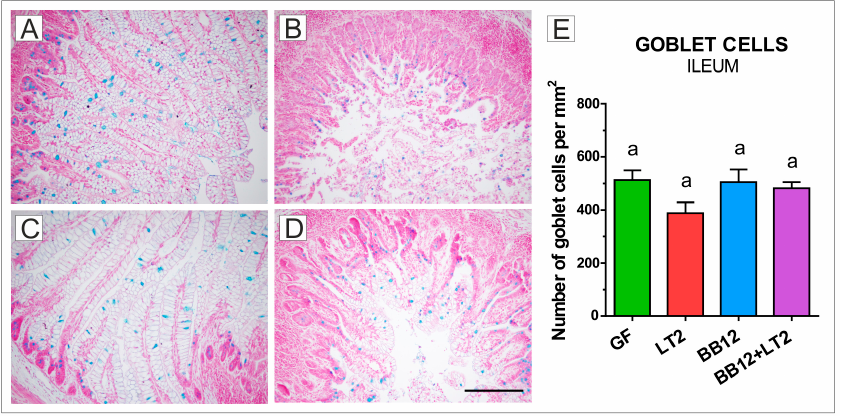
Figure 1. Goblet cells (blue color) in the ileum of gnotobiotic piglets. Number of goblet cells per mm 2 in the ileum of the one-week-old piglets: germ-free (GF; ( A )), infected with S . Typhimurium LT2 for 24 h (LT2; ( B )), associated with B. animalis subsp. lactis BB-12 (BB12; ( C )), and associated with BB12 and infected with LT2 for 24 h (BB12 + LT2; ( D )). Six samples from each group were analyzed, and statistical differences were calculated by a two-way ANOVA with Tukey’s multiple comparison post hoc test. The values are presented as mean + SEM, and p < 0.05 among groups are denoted by different letters above the columns ( E ). A scale bar ( D ) depicts 200 µ m.